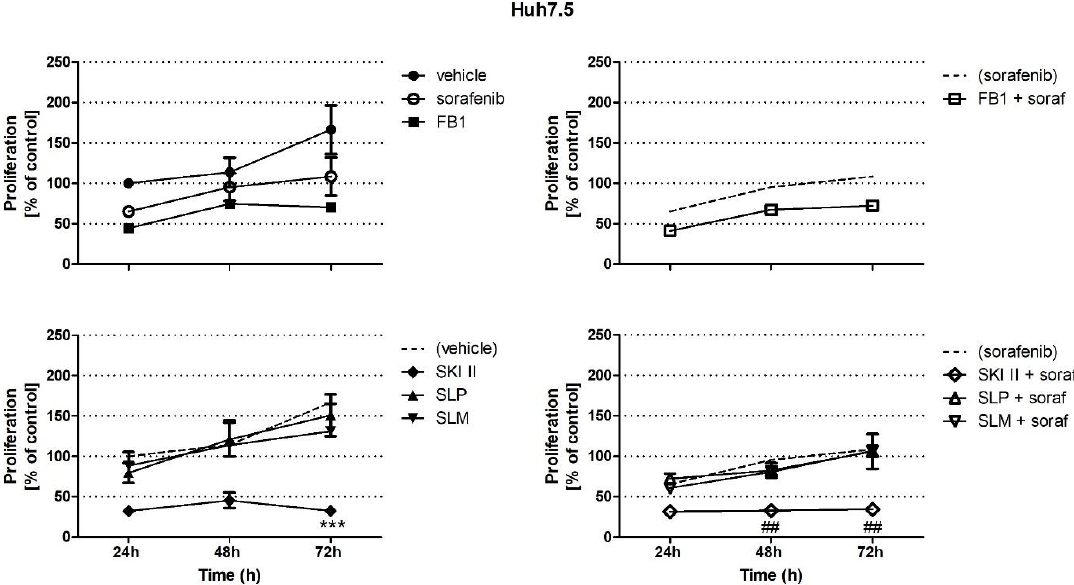
Figure 2. Influence of sorafenib, FB1, and SPHK inhibitors on the proliferation of Huh7.5 cells. Cell proliferation was analyzed by measuring the incorporation of radioactively labeled thymidine. The cells were pretreated with 25 µ M FB1 for 1 h, or with 10 µ M SKI II, 1 µ M SLP, or 1 µ M SLM for 2 h. Then, vehicle (control; 0.2 % DMSO) or 5 µ M sorafenib (soraf) were added for the indicated periods of time. All data are derived from three independent experiments performed in triplicate, which comprised all conditions; FB1 was included in two of these experiments. The dashed lines repeatedly indicate vehicle control or sorafenib as shown in the upper left panel. The values are means ± SEM and expressed relative to vehicle control at 24 h. *** p < 0.001 compared to control; ## p < 0.01 compared to sorafenib in Two-way ANOVA.